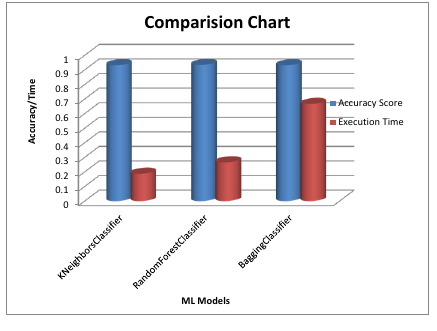
Figure 9. Comparison Chart of ML